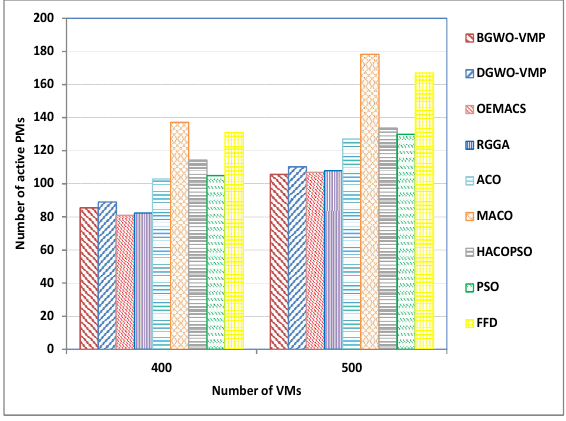
Figure 5. Number of active PMs for heterogeneous instances of large-sized problems B4 and B5.